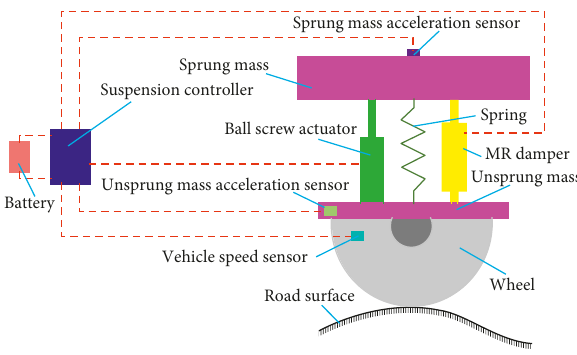
Figure 1: Structure of the hybrid active